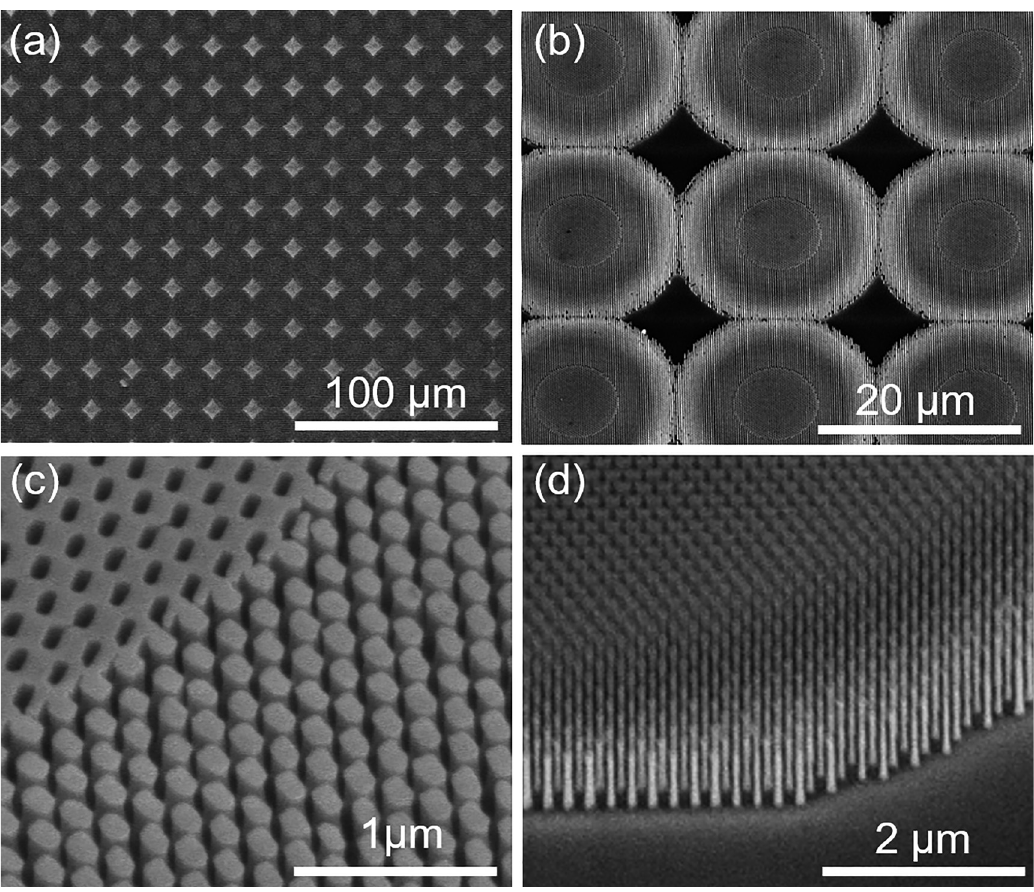
Figure 2: SEM images of the achromatic meta-lens array. (a) and(b) Zoomed-inSEM image of the achromaticmeta-lens array. (c) and(d) Tilted-viewzoomed-inSEM image of the achromaticmeta-lens array. The tilted angle is 30 ° and 45 ° , respectively.